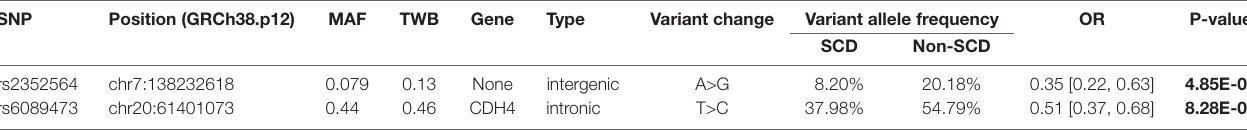
TABLE 3 | Association between all non-migraine controls grouped by SCD group a . SNP Position (GRCh38.p12) MAF